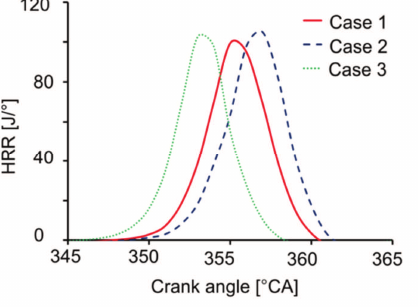
Fig. 4. Heat release rate for chosen cases (Table 4)